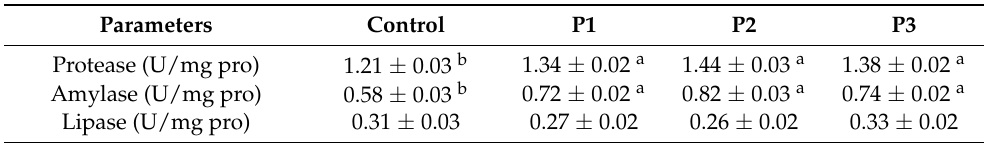
Table 5. Digestive enzymes activity of rainbow trout fed four experimental diets with different inclusion levels control: 0, P1: 5, P2: 10, and P3: 20 g of apple pomace derived pectin (APDP)